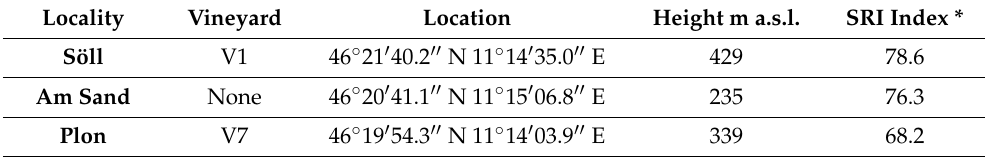
Table 3. Position of the environmental air and soil monitoring stations used in this study. Locality Vineyard Location Height m a.s.l. SRI Index * Söll